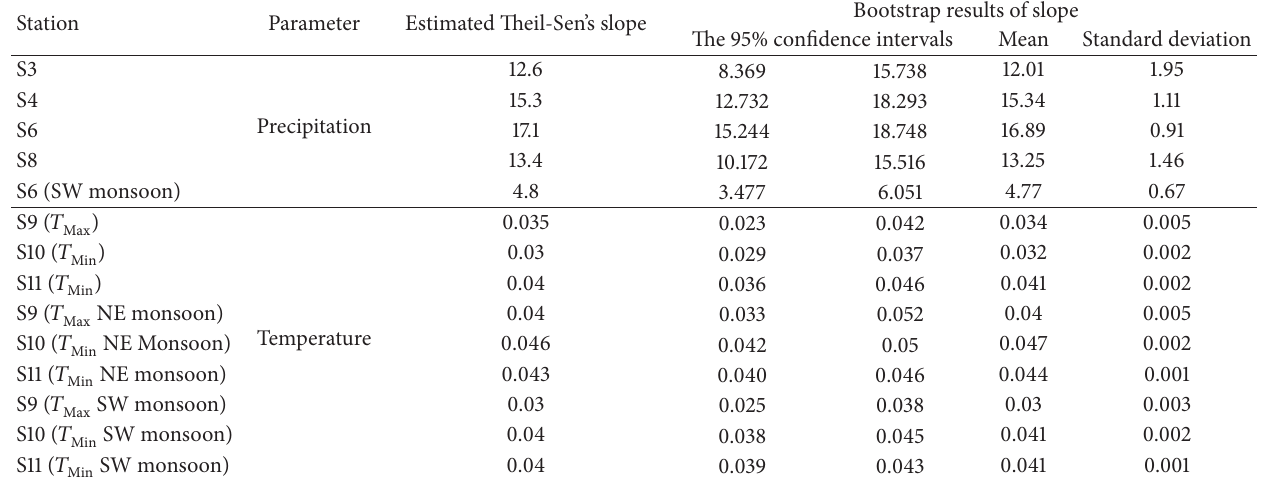
Table 8: The bootstrap results for slopes in significant trends for rainfall and maximum and minimum temperatures in the Langat River Basin. Station Parameter Estimated Theil-Sen’s slope